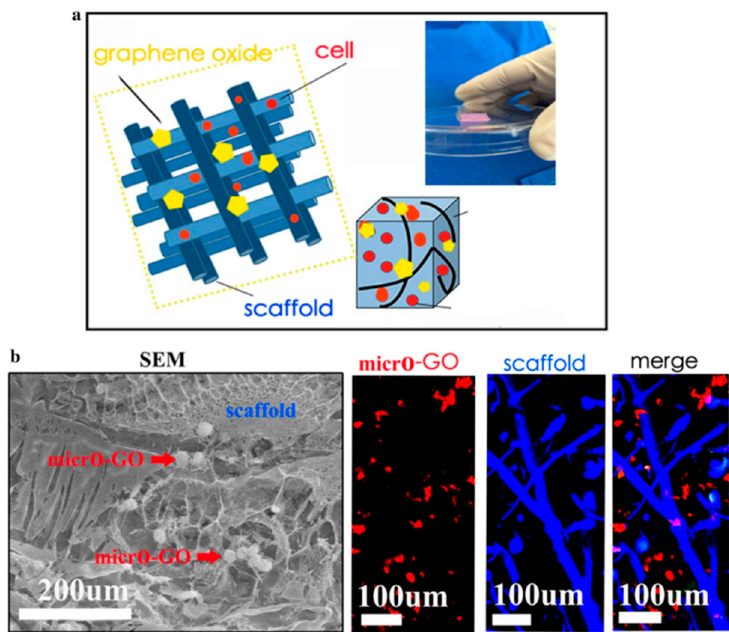
Figure 3. 3D-printed scaffold containing graphene oxide (GO) for the cartilage layer construction. ( a ) Scheme of 3D-printed scaffold containing GO and chondrocytes (cells), ( b ) SEM and immunofluorescence in vitro evaluation of micro-GO presence in scaffold. The scaffold (in blue color) forms nets, in which micro-GO (in red color) and chondrocytes are localized. Micro-GO are flakes with length less than 100 µm. Toluidine blue and 1,1-dioctadecyl-3,3,3,3-tetram-ethylindocarbocyanine perchlorate (DiI; Sigma, St. Louis, MO, USA) were used to label micro-GO flakes within the scaffold. Adapted from [83], BMC, 2020.